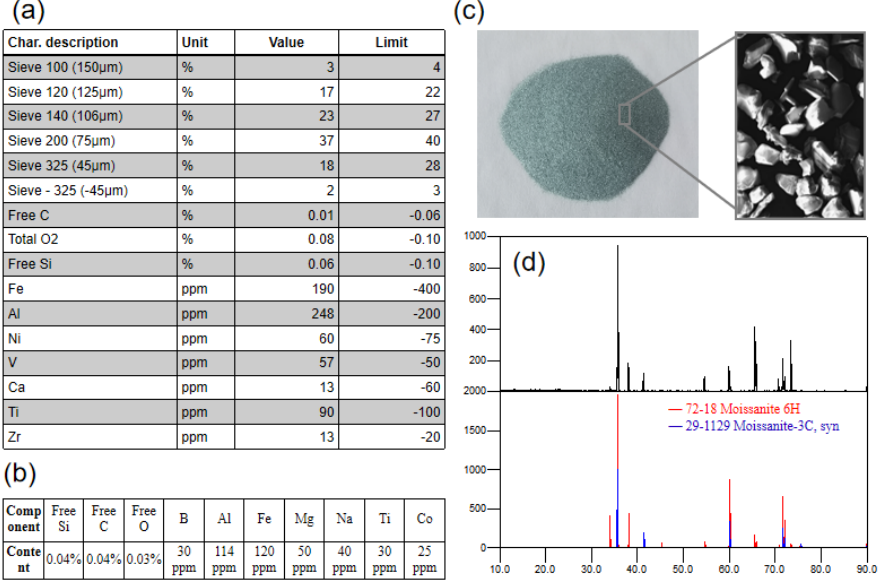
Figure 2. ( a ) Factory specifications; ( b ) GDMS results; ( c ) powder; ( d ) XRD patterns.